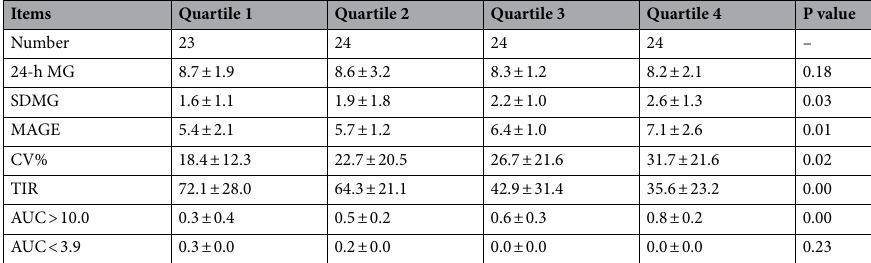
Table 2. Glycemic profiles in recruited subjects across 4 quartiles of ErbB2 concentrations. Data were presented as means ± SD, *P < 0.05. 24-h MG 24-h mean glucose concentrations (mmol/L), SDMG 24-h standard deviation of mean glucose concentrations (mmol/L), MAGE 24-h mean amplitude of glycemic excursions (mmol/L), CV% the coefficient of variation (%), TIR time in range from > 3.9 mmol/L to < 10.0 mmol/L (%), AUC > 10.0 mmol/L the incremental AUC of glucose level above 10.0 mmol/L (mmol/ L*Day), AUC < 3.9 mmol/L the incremental AUC of glucose less than 3.9 mmol/L